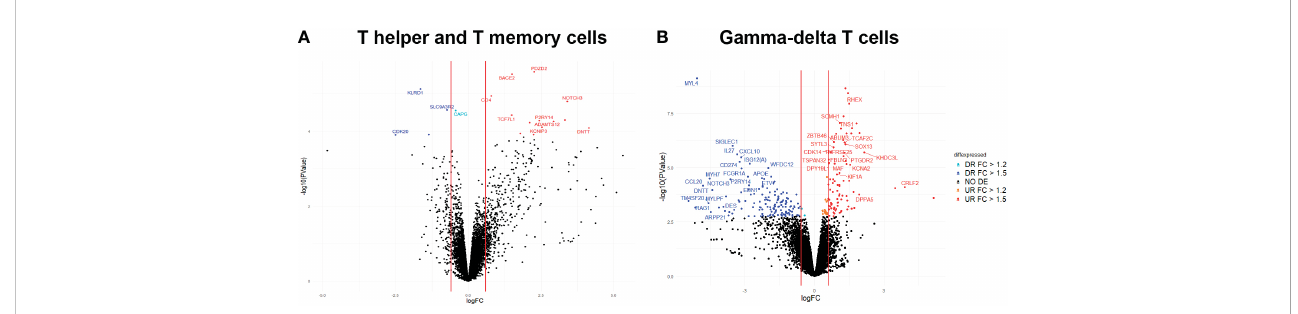
FIGURE 3 Volcano plot displaying DE genes in blood between H and L groups for (A) T helper and memory T-helper cell and (B) dg T cells. The vertical axis (y-axis) corresponds to the -log10 (P-value), and the horizontal axis (x-axis) displays the log 2 fold change (logFC) value. The vertical lines mark the thresholds located to FC = 1.5 and FC = -1.5. Blue dots represent downregulated genes in HvsL groups with FC< -1.5 and FDR< 0.1. Cyan dots represent downregulated genes in HvsL groups with -1.5< FC< -1.2 and FDR< 0.1. Red dots represent upregulated genes in HvsL groups with FC > 1.5 and FDR<